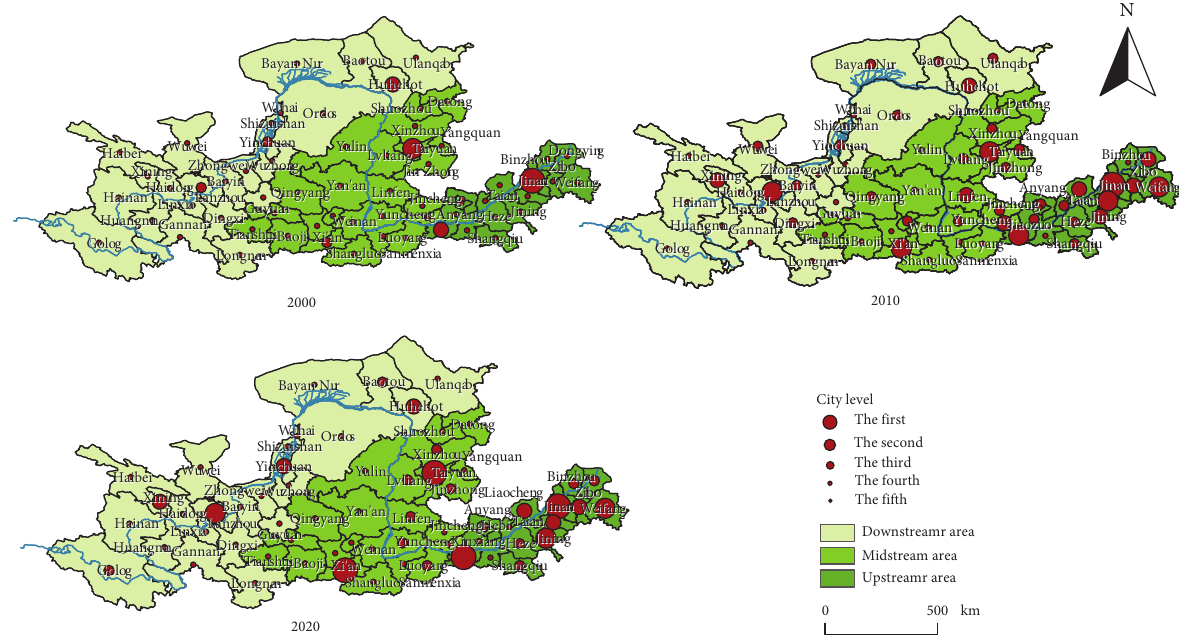
Figure 1: Hierarchical distribution map of river basin urban network